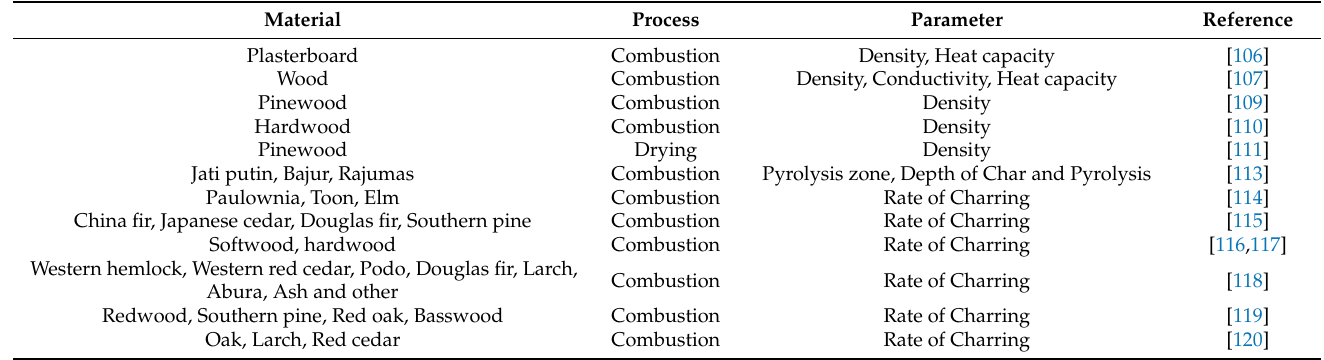
Table 4. Wooden materials